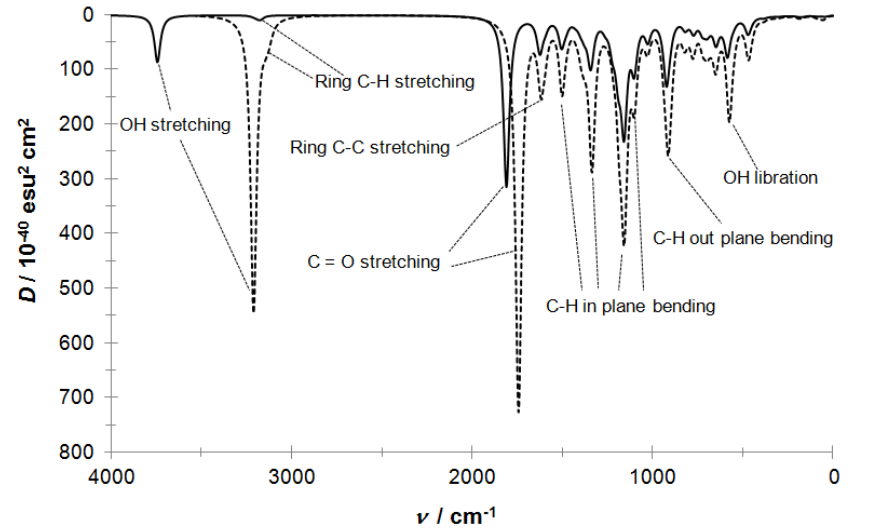
Figure 3: Theoretical IR spectra of quinclorac in the gas (solid line) and aqueous (broken line) phases obtained at the B3LYP/6-311++G(2d,2p) level. Table 1: Electronic energies in hartrees for quinclorac at the level MP2/6-311++G(2d,2p).